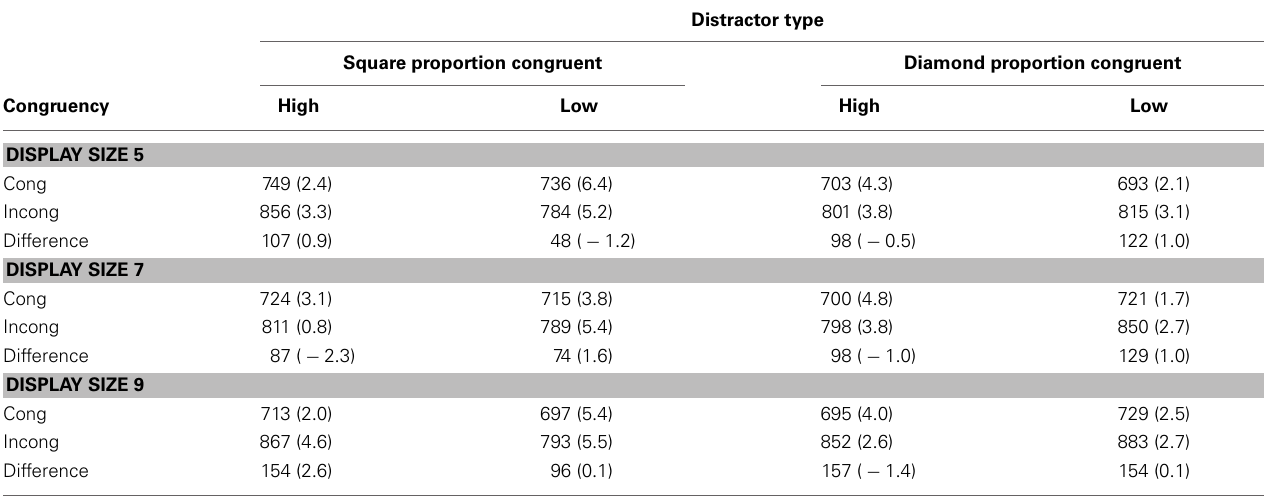
Table 1 | Mean response times and error percentages (in parentheses), collapsed across block, for each condition in Experiment 1.